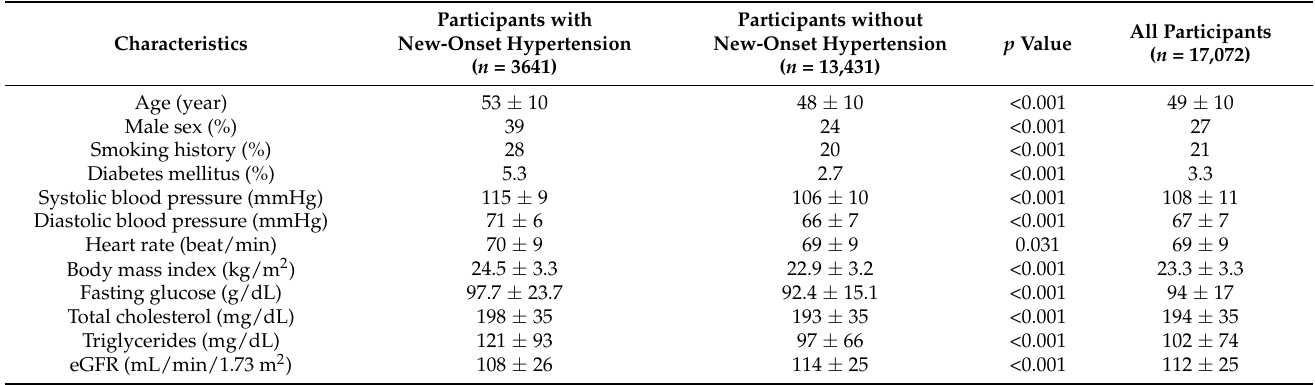
Table 1. Comparisons of baseline characteristics in the new definition population (hypertension was defined as systolic blood pressure ≥ 130 mmHg or diastolic blood pressure ≥ 80 mmHg).